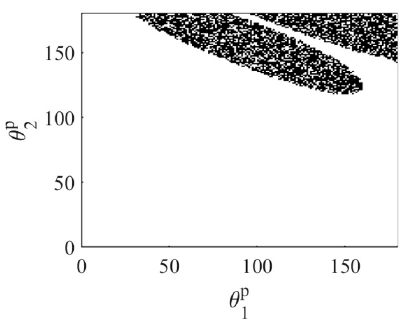
Figure 9. Two-dimensional C-space based on random sampling.